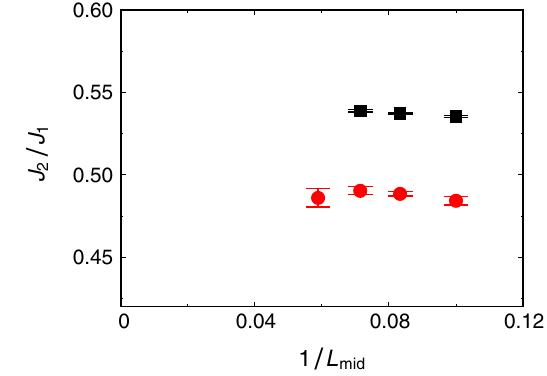
FIG. 16. System-size dependence of the crossing points of the correlation ratio for spin-spin (red dots) and dimer-dimer (black squares) correlations, which are used to determine the phase boundary of N ´ eel-AFM and VBS, respectively. We focus on the crossing of the curves between the L 1 × L 1 and L 2 × L 2 lattices with ð L 1 ; L 2 Þ ¼ ð 8 ; 12 Þ , (8,16), (12,16), and (16,18) for spin-spin correlations, and ð L 1 ; L 2 Þ ¼ ð 8 ; 12 Þ , (8,16), and (12,16) for the L L = 2 dimer-dimer correlations. L is defined as L 1 þ 2 Þ mid mid ¼ ð